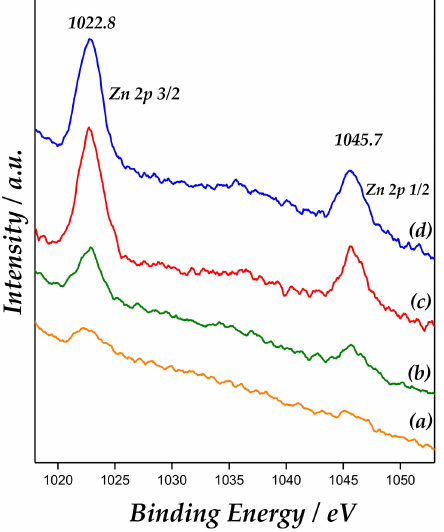
Figure 5. X-ray photoelectron spectroscopy (XPS) spectra of Zn 2p 3/2 and Zn 2p1 /2 for the catalysts: (a) Zn/MCM-41(1), (b) Zn/MCM-41(2.5), (c) Zn/MCM-41(10), and (d)